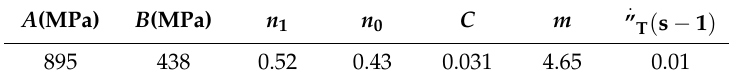
Table 2. Values of the modified KHL model constants for TC11.